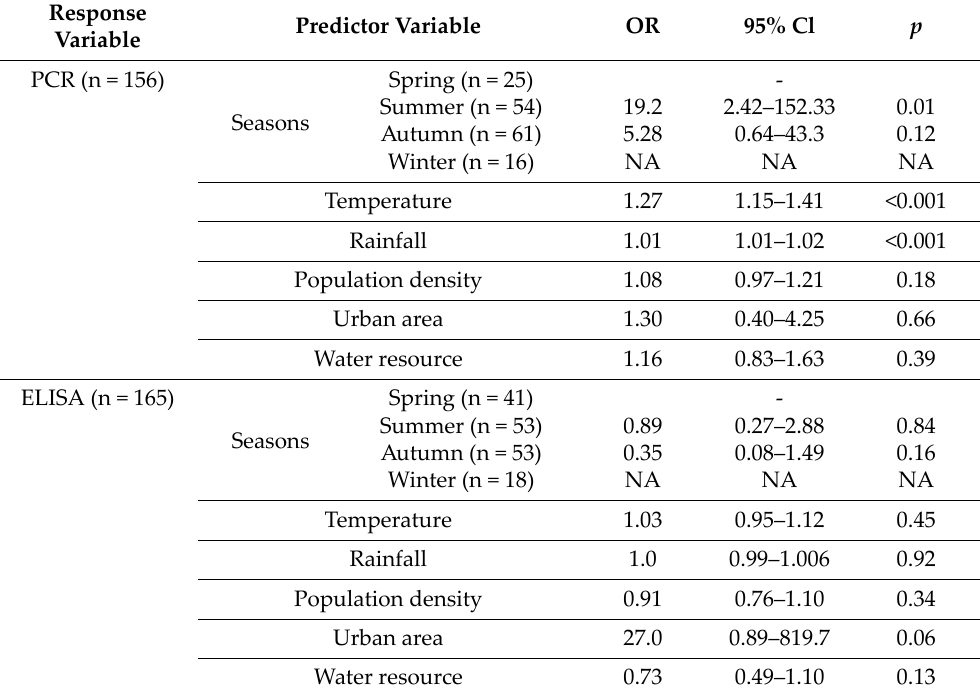
Table 2. Univariate logistic regression analysis estimates the factors responsible for leptospiral